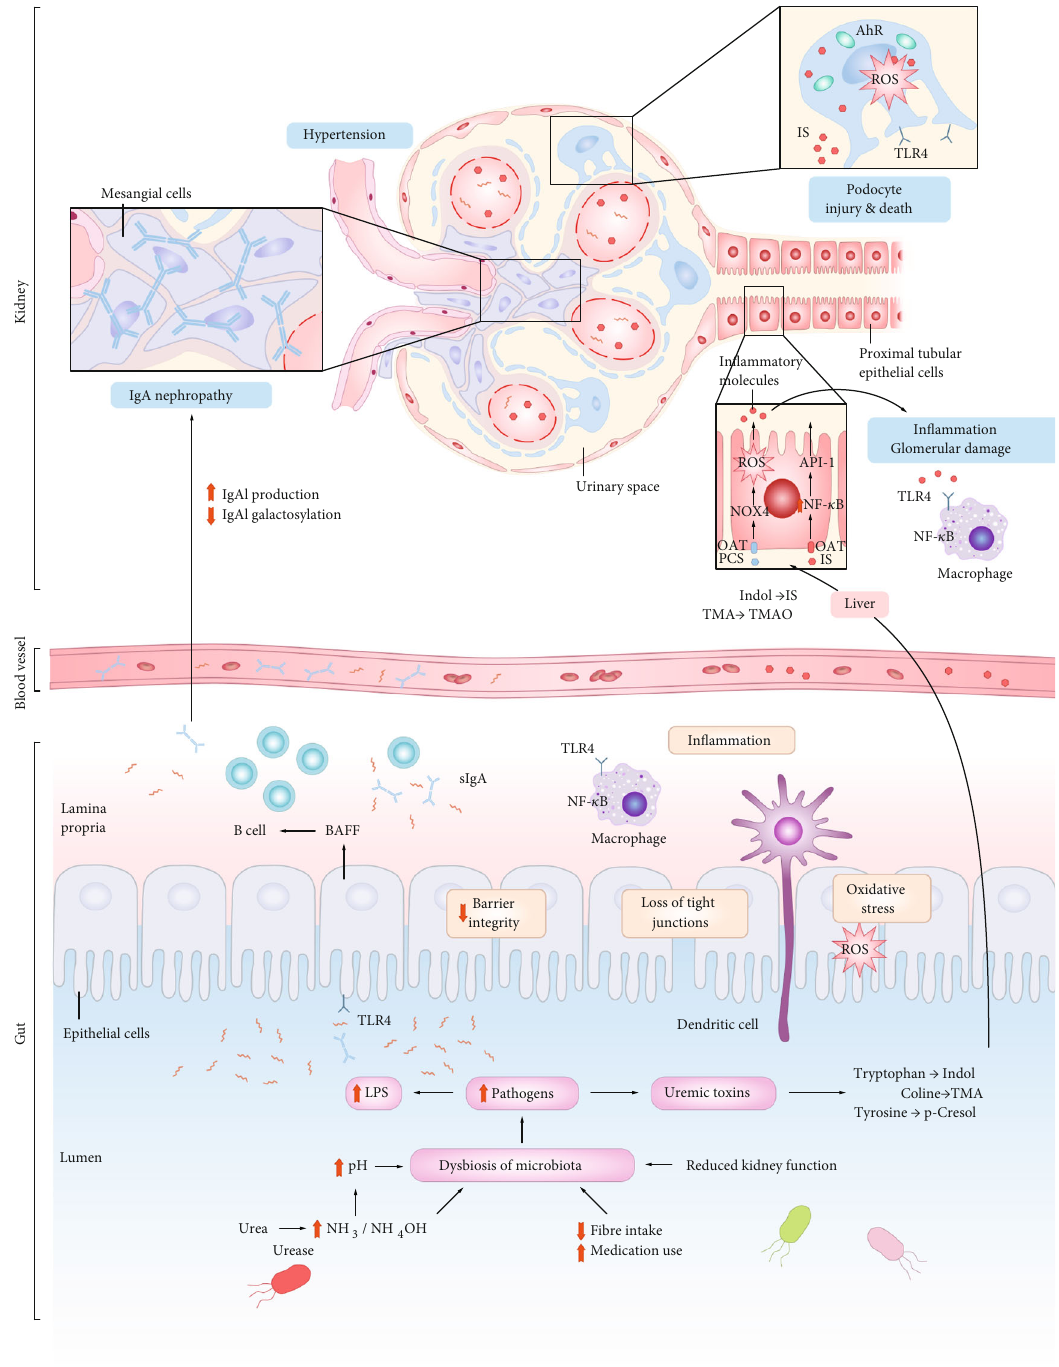
Figure 3: Changes in diet, numerous medication use, and decreased kidney function in CKD patients may lead to intestinal dysbiosis. The digestive tract becomes the main route for urea excretion in CKD patients with impaired renal function. A large amount of NH3 or NH4OH which are produced by bacteria can increase the intestinal pH value, promote the intestinal dysbiosis and destroy intestinal barrier. Thus, the transport of endotoxins (e.g., lipopolysaccharides (LPSs)) into the bloodstream has di ff erent e ff ects on systemic in fl ammation, oxidative stress, cardiac injury, and atherosclerosis. Dysbiotic gut-derived uremic toxins, such as indoles and phenols, are further metabolized into trimethylamine N-oxide (TMAO), indoxyl sulfate (IS), and p-cresyl sulfate (PCS) in the liver and colon. The introduction of uremic toxins into the circulation causes in fl ammation and tubulointerstitial damage and promotes ROS production, tubulointerstitial damage, and nephrotoxicity of proximal tubuloepithelial cells. Intestinal microbial metabolites SCFAs are associated with hypertension and are important risk factors for CKD. SCFAs trigger hypertension through Olfr78, leading to renin secretion and regulation of peripheral resistance. In addition, bacteria and their components are involved in the hyperproduction and hypogalactosylation of